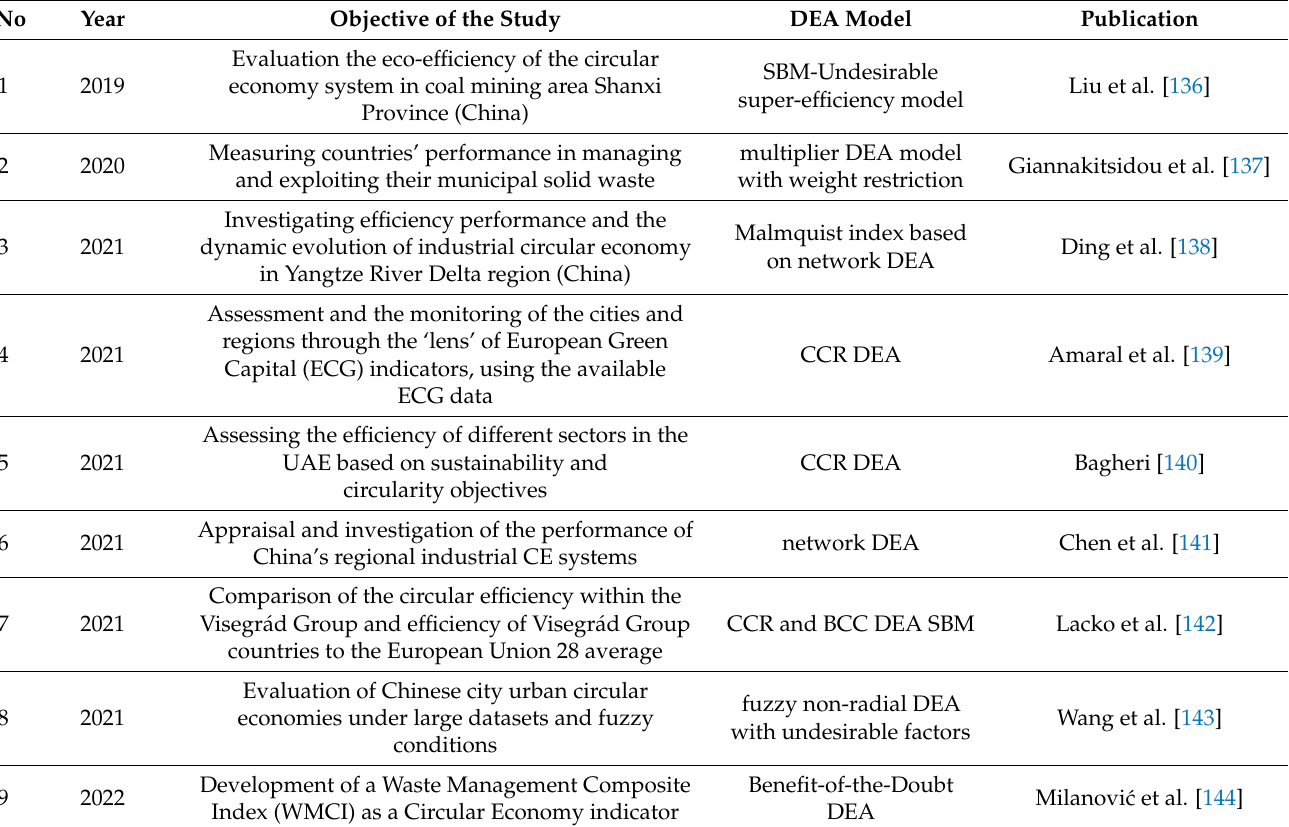
Table 1. DEA applications in assessing the implementation of the circular